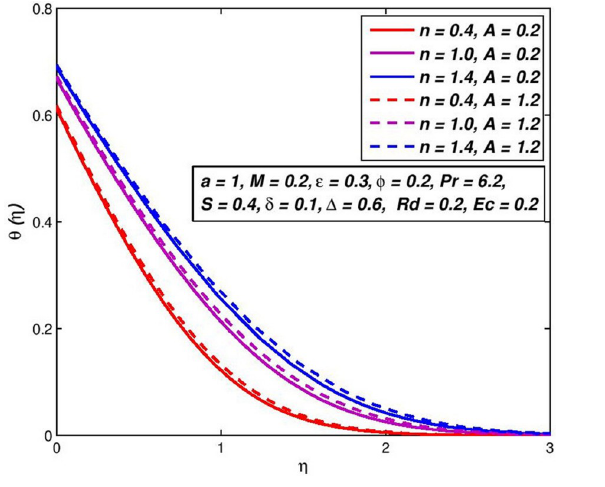
Fig 5. Effect of A on θ ( η ) for diverse n values.